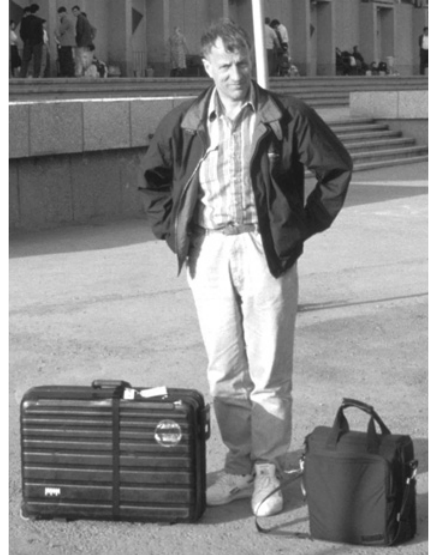
Fig. 2. J.-E. Solheim with the Pancake and its computer at the Tashkent airport in